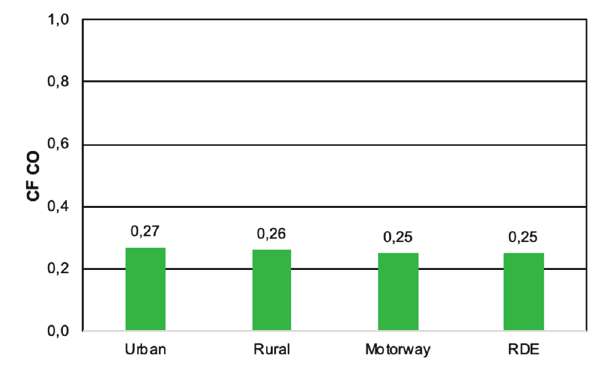
Fig. 11. CF for CO emissions in respective phases of RDE cycle and average CO emission in this cycle